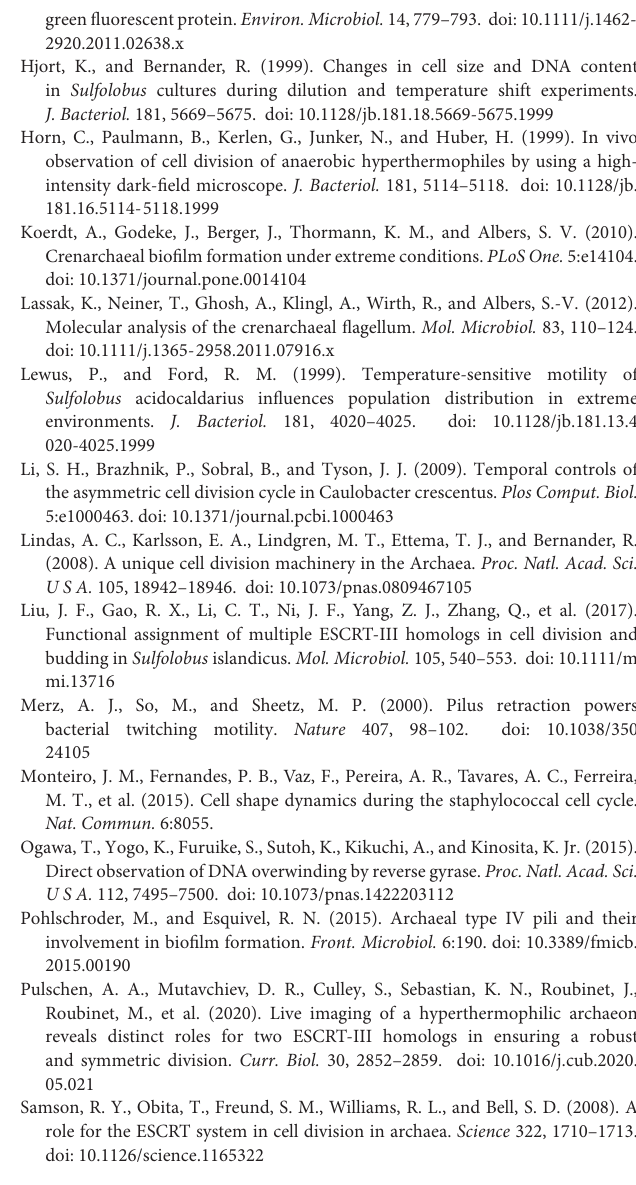
Supplementary Figure 2 | Frequency of cell divisions during live-cell imaging at 75 ◦ C. Supplementary Figure 3 | S. acidocaldarius exhibit dynamic “kiss-and-run” cell-cell interactions. Snapshots from a representative movie showing cells undergoing highly dynamic and transient cell-cell interactions. Cells were manually colorized for clarity. Also see Supplementary Movie 3 . DIC, 75 ◦ C, 100X + 1.5X lens. Time is provided in